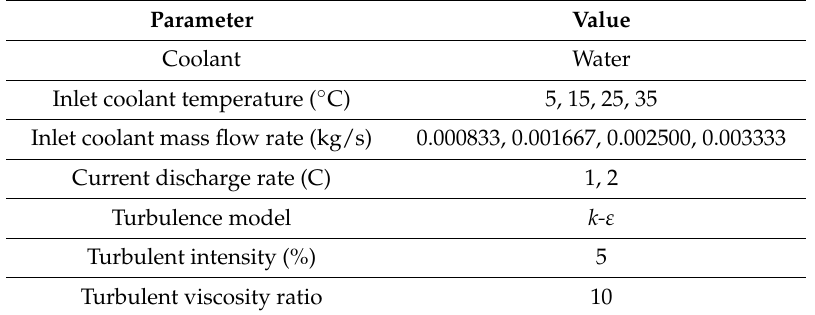
Table 3. Boundary conditions.